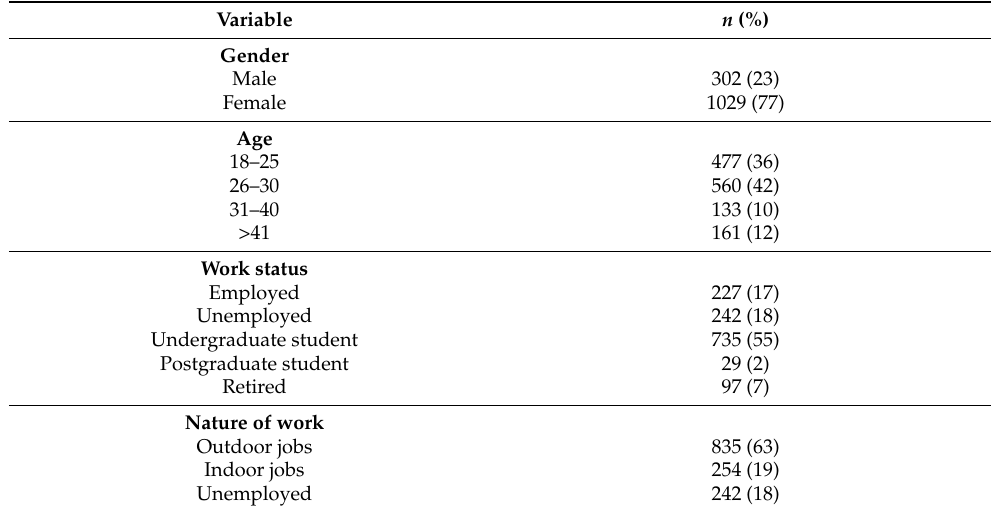
Table 1. Participant characteristics ( n = 1331).